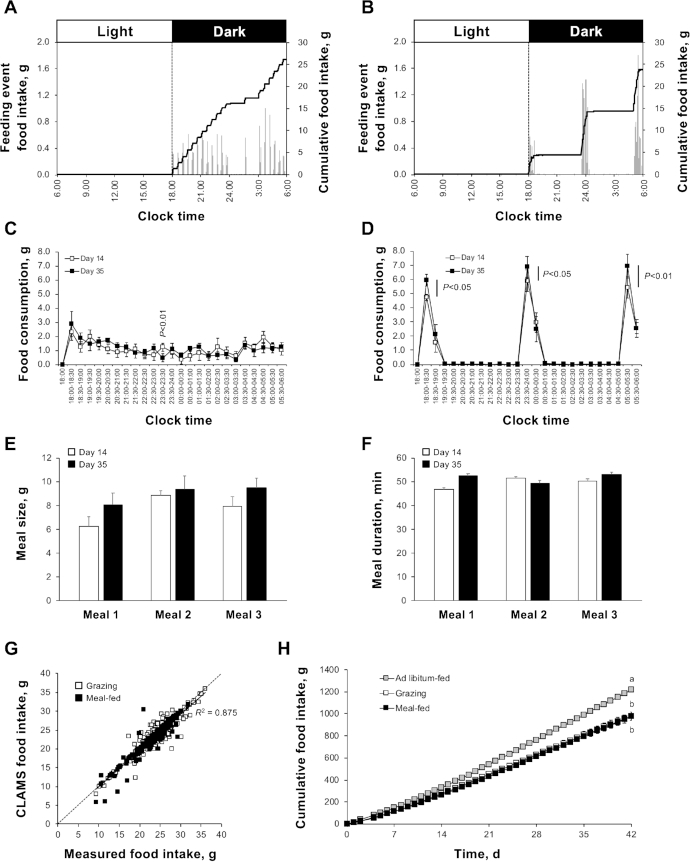
Delivery of StD in standard grazing and meal-feeding patterns in male rats (study 1). Representative daily food intake profiles from day 14 of a 6-wk study in grazing (A) and meal-fed (B) rats consuming StD (13.9% Atwater Fuel Energy fat). Each profile shows cumulative food intake (black line; right-hand axes) superimposed onto the individual feeding events (gray bars; left-hand axes). Comparison of the mean day-14 and day-35 food consumption profiles in grazing (C) and meal-fed (D) rats is shown, with quantification of the size (E) and duration (F) of the individual meals in meal-fed animals. Regression analysis of the Comprehensive Laboratory Animal Monitoring System output data with manual quantification of daily food consumption is shown (G; regression conducted for all data points; dashed line shows parity), with cumulative food consumption across the 6-wk study presented (H). Apart from the representative individual profiles (A, B), data shown are means ± SEMs [C–F, H; n = 6 (grazing) and 5 (meal-fed)] with statistical comparisons performed by either paired Student's t test (C, D) or 1-factor ANOVA and Bonferroni's selected-pairs post-hoc test (E, F, H) (means without a common letter differ, P < 0.05). Note: a group of ad libitum–fed rats (H; gray symbols; n = 8) was monitored in parallel to calculate food intake allowance for application to grazing rats. StD, standard nonpurified rodent diet.